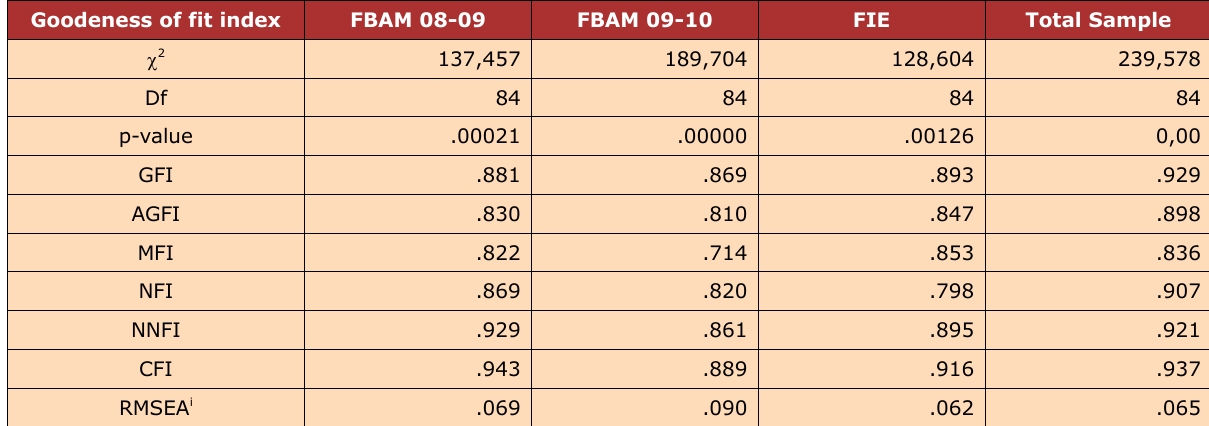
Table 1. Goodness of fit indexes of the three subgroups and the total sample